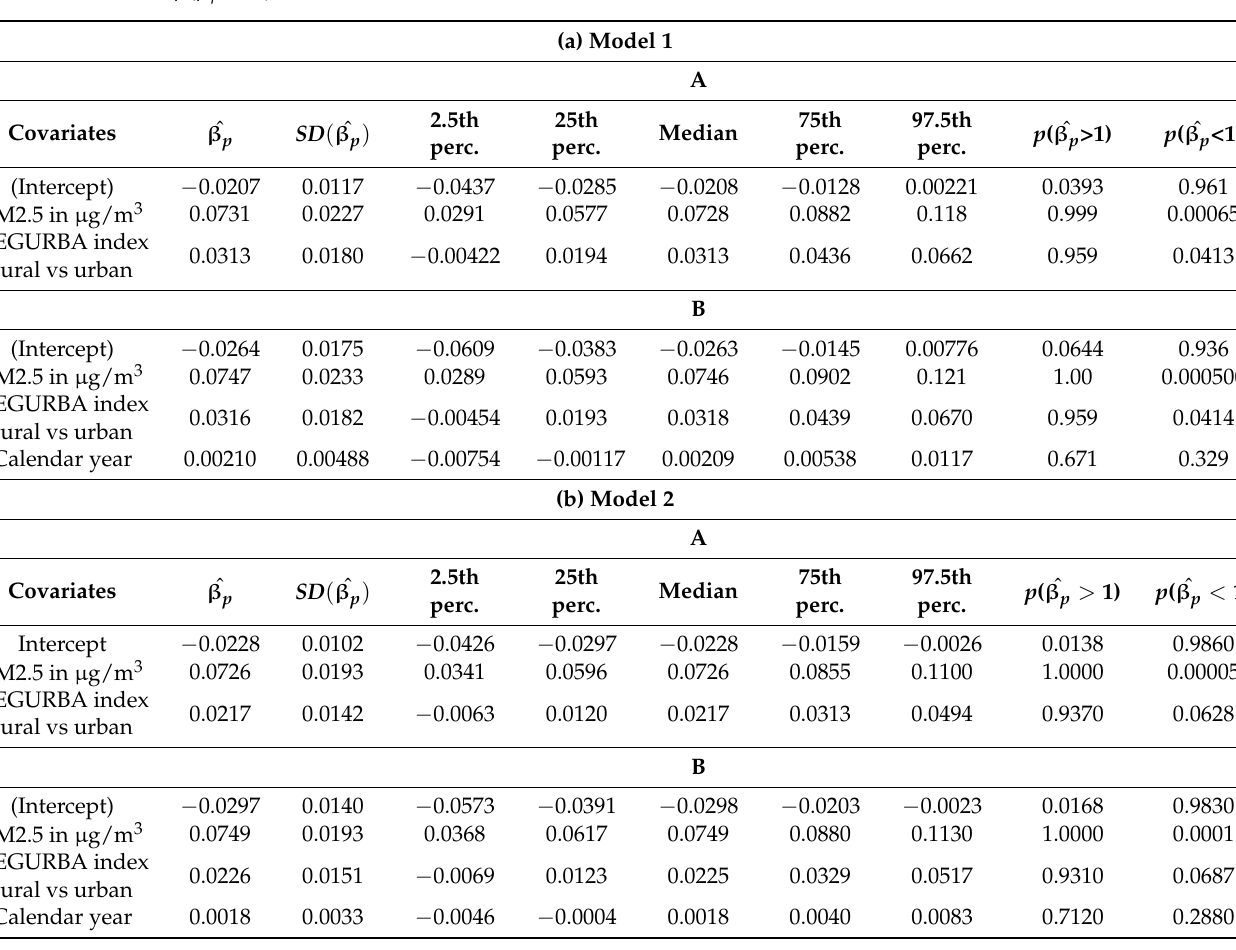
Table A2. Output of all fitted models. Posterior probabilities (PPs) can be seen as “ p -values” complementary to 1. The first column is the mean of the marginal posterior distributions (MPDs) of a parameter (OR) and the second column is with the standard deviation of that parameter. The following 5 columns are the percentiles (perc.) of MPD. Finally, the last two columns show the posterior probability (PP) that the estimated parameters are more, p ( ˆ β p > 1 ) , or less, p ( ˆ β p < 1 ) , than 1. A predictor was defined as a risk factor if it has a p ( ˆ β p > 1 ) close to 1; conversely, a parameter associated with a protective factor will have p ( ˆ β p < 1 ) close to